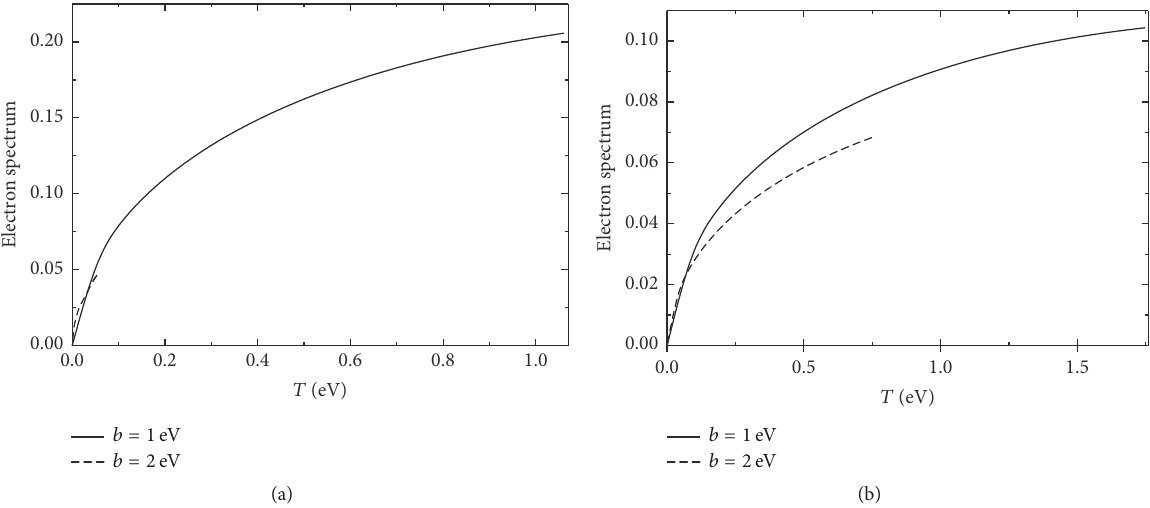
Figure 7: The same as in Figure 6, but for 𝑥 = 10 in panel (a) and 𝑥 = 20 in panel (b). In both cases only electrons with 𝑏 < 3 eV can be ejected. Notice, however, that the spectrum is suppressed for 𝑏 = 2 (dashed line) compared to the corresponding one for 𝑏 = 1 (solid